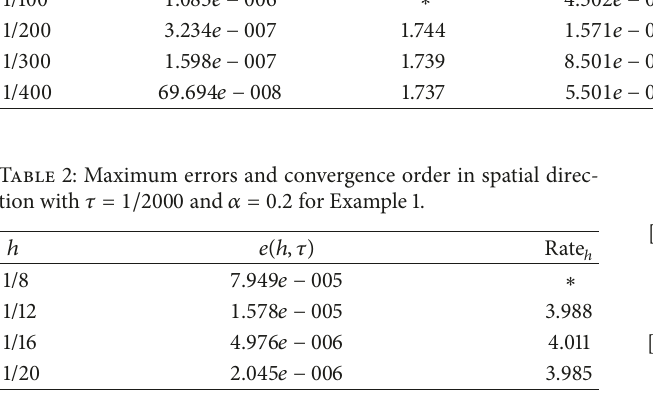
Table 1: Maximum errors and convergence order in temporal direction with ℎ = 1/400 and 𝛼 = 0.3, 0.5, 0.8 for Example 1. 𝛼 = 0.3 𝛼 = 0.5 𝛼 = 0.8 𝜏 𝑒(ℎ, 𝜏) Rate 𝑒(ℎ, 𝜏) 𝑒(ℎ, 𝜏) Rate 𝜏 1/100